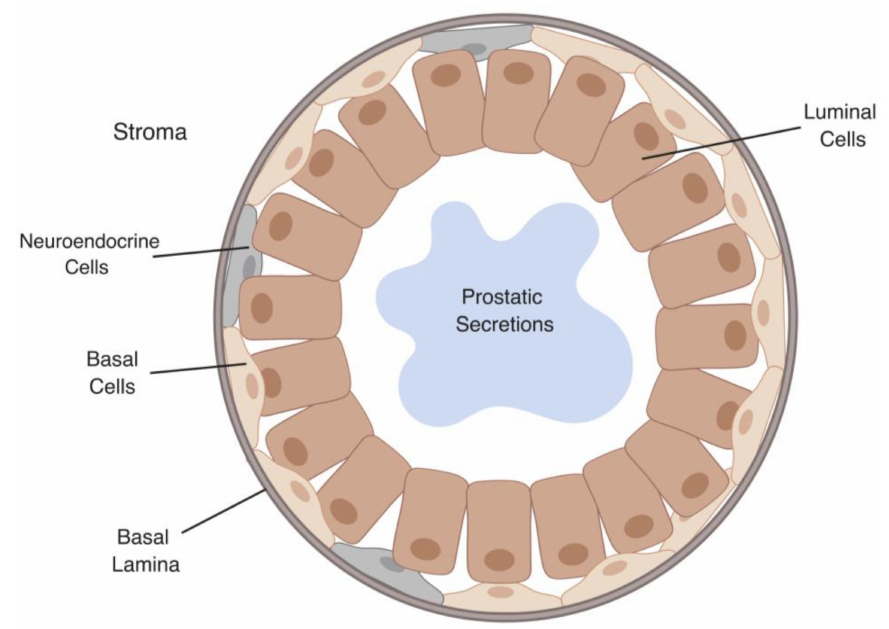
Figure 1. Representation of di ff erent cell types in the prostate